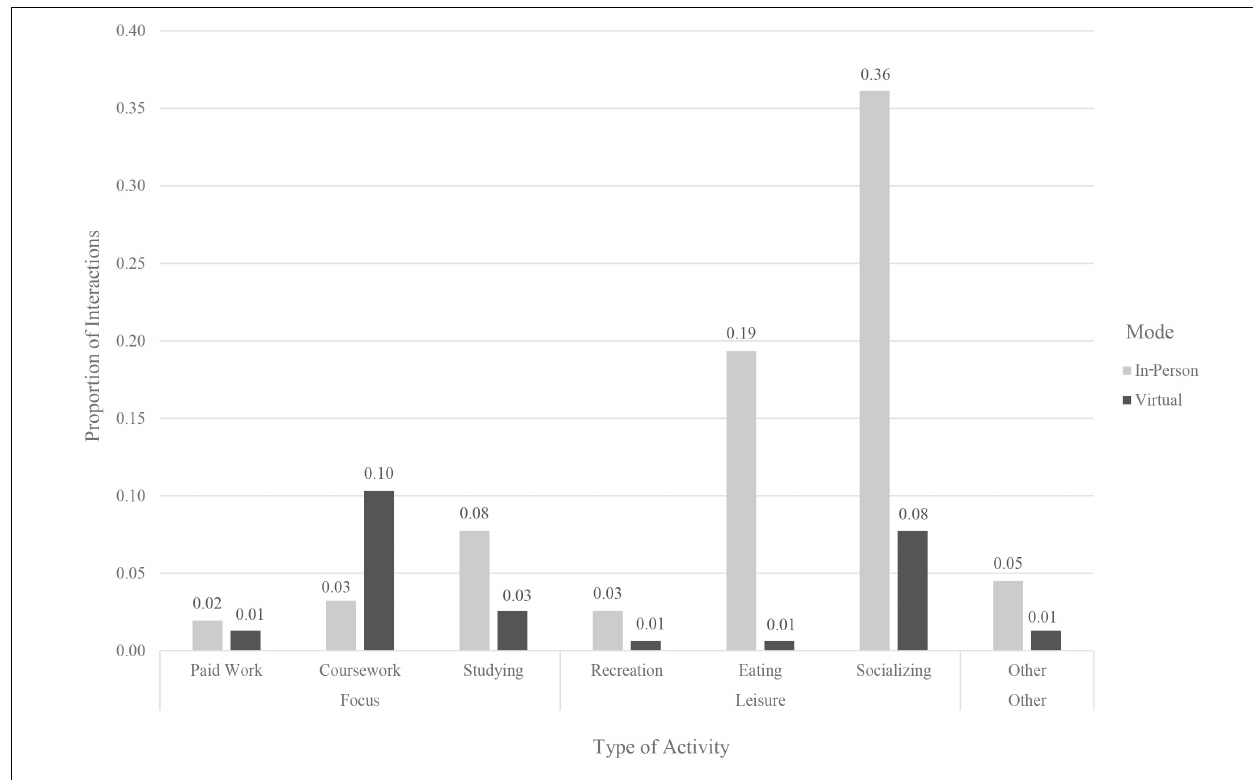
FIGURE 3 | Proportion of type of activity occurring during interaction.